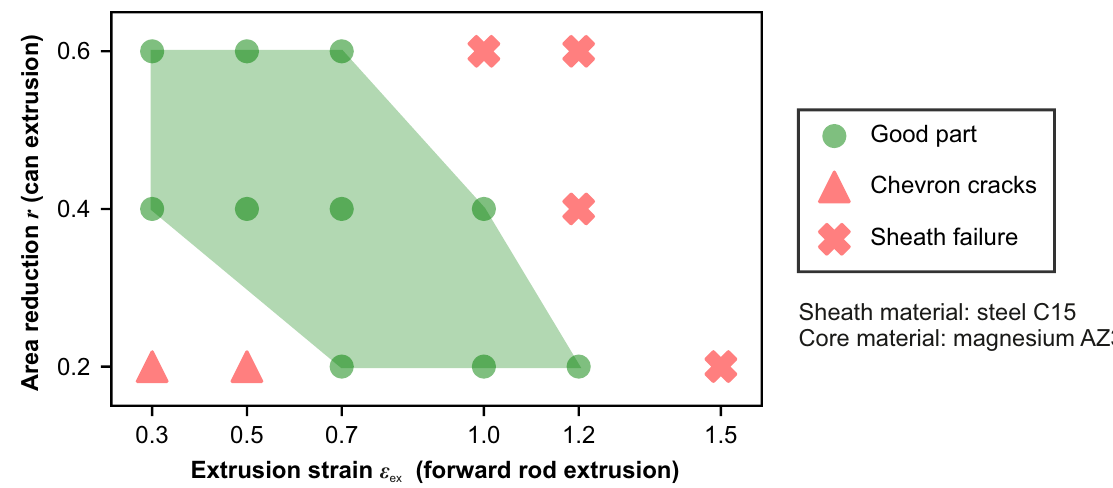
Figure 7. Process window of magnesium-steel composite forward rod extrusion.